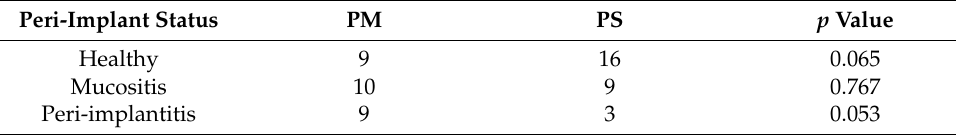
Table 2. Prevalence of peri-implant diseases of the study